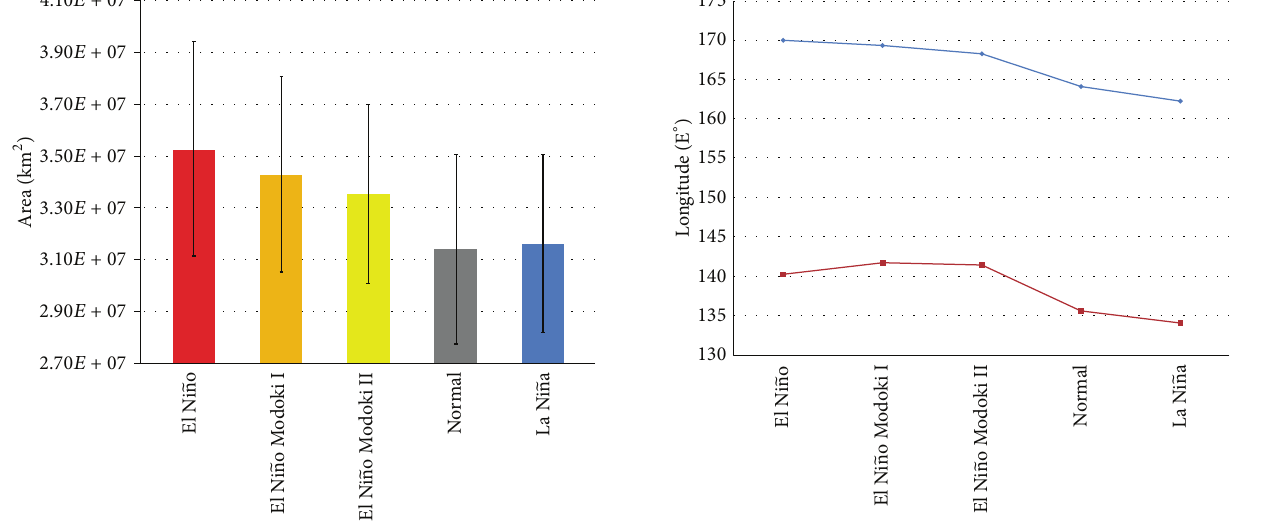
Figure 8: The centroid of WPWP (Blue) and the formation position of typhoon (Red) in five